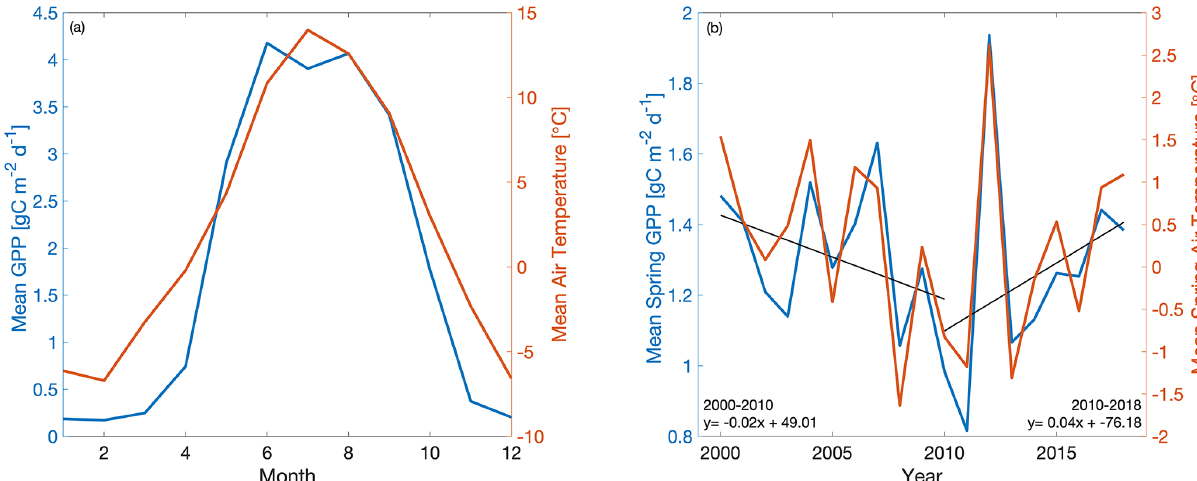
Figure 1. Time series of (a) mean monthly GPP (blue) and air temperature (orange) and (b) mean spring (March–May) GPP and air temperature at Niwot Ridge (US-NR1) from 2000–2018. GPP data are derived using a nighttime partitioning technique based on tower observations of NEE and air temperature.